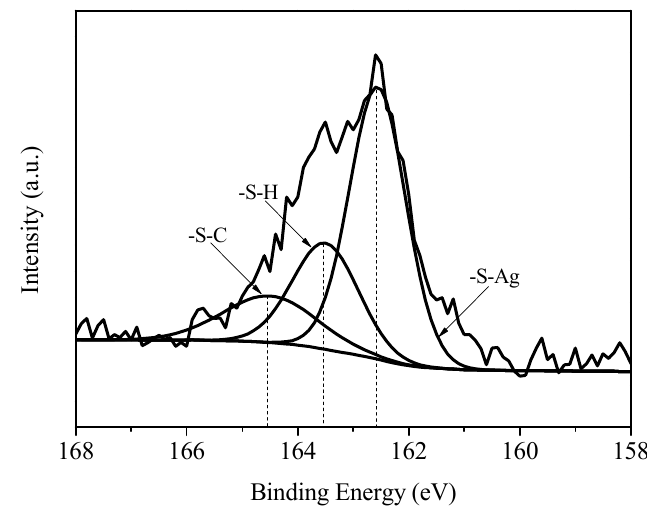
Figure 7. S 2p XPS spectra of NH2-AgNWs.